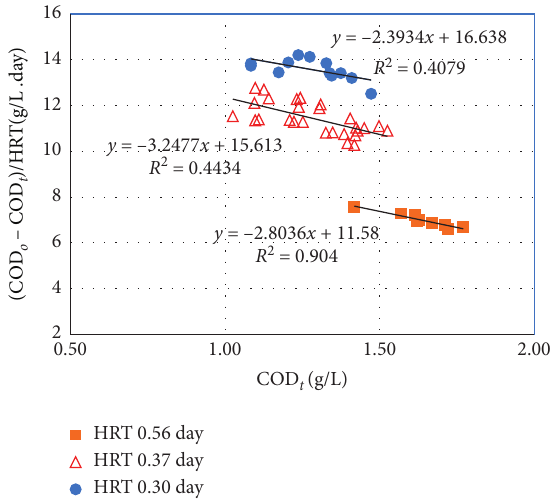
Figure 6: Monod model plot of COD removal in the pilot-scale MBBR at different